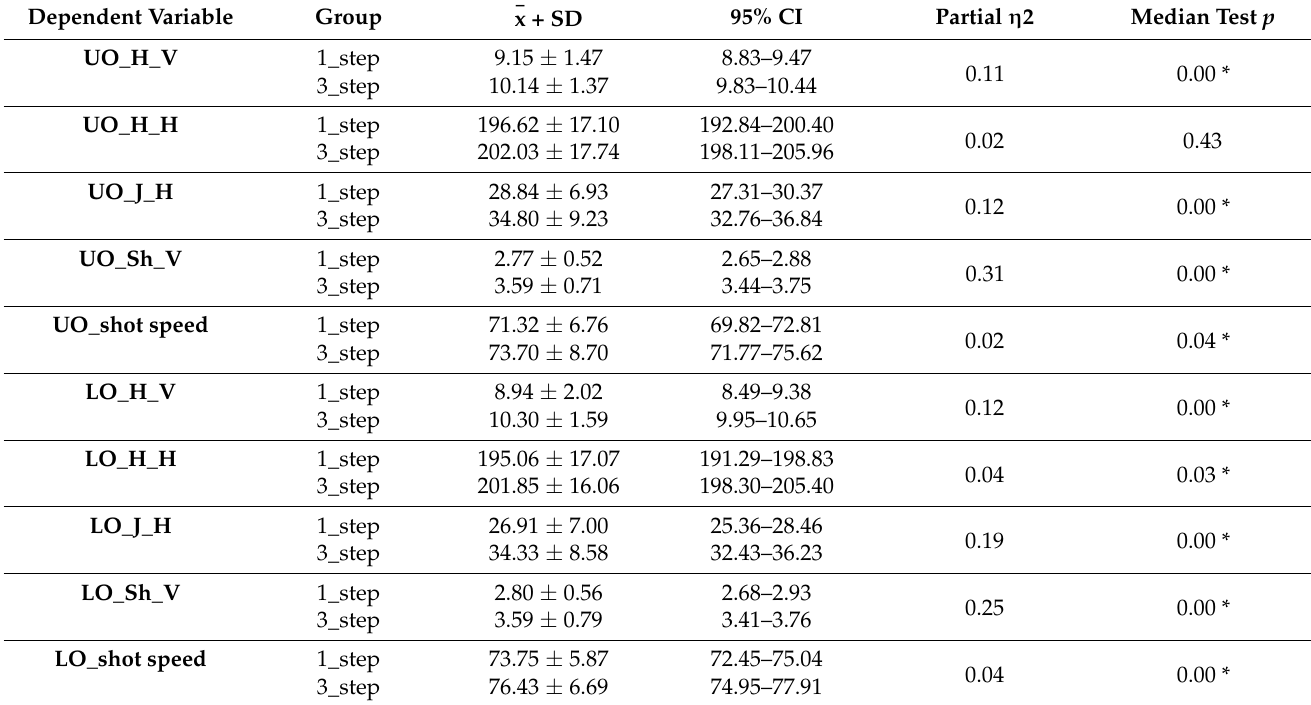
Table 2. Basic descriptive parameters and Median test results of two different variations of jump shot